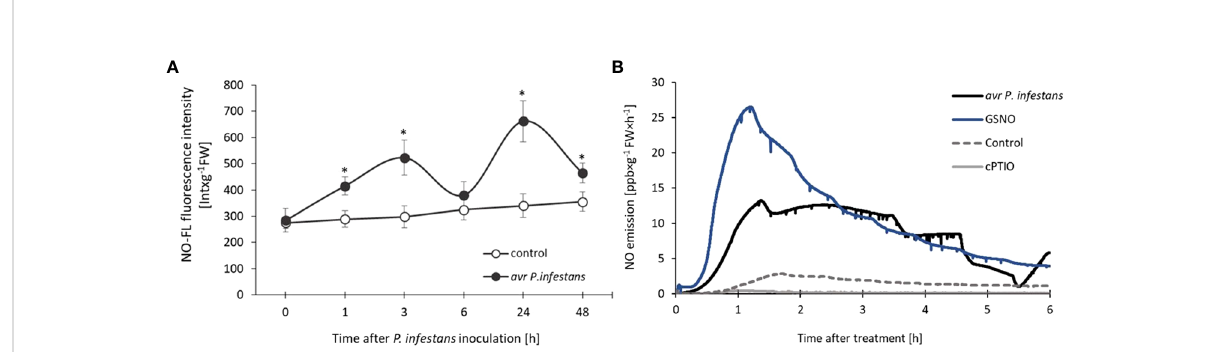
FIGURE 1 Nitric oxide generation in potato leaves of resistant ‘ Sarpo Mira ’ challenge inoculated with avr P . infestans measured by fl uorescence method (A) , NO emission from leaves treated with the pathogen, 250 µM GSNO, 200 µM cPTIO, or H 2 O, measured by chemiluminescence using an ultra-high selective NO analyzer (B) . In (A) NO-FL fl uorescence from extracts of control and inoculated potato leaves was determined as described in the Materials and methods. Each value was expressed as NO-FL fl uorescence intensity in Int × g -1 FW. Values represent the means of data ± SD of three independent experiments. Asterisks indicate values that differ signi fi cantly from those for control leaves at a <0.05 ( ∗ ). In (B) chemiluminescence rate of NO emission was expressed in ppb × g -1 FW × h -1